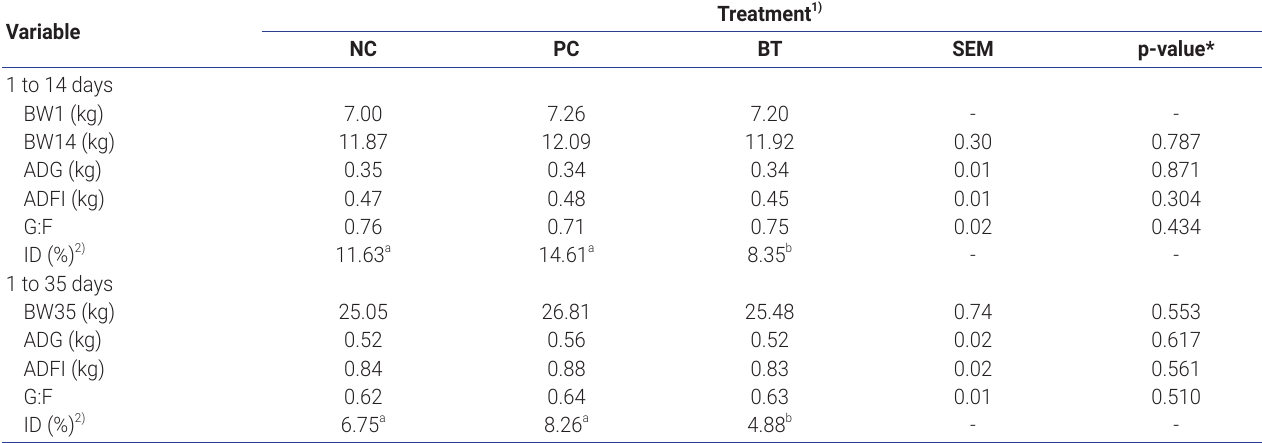
Table 2. Mean values for the experimental periods of 1 to 14 and 1 to 35 days